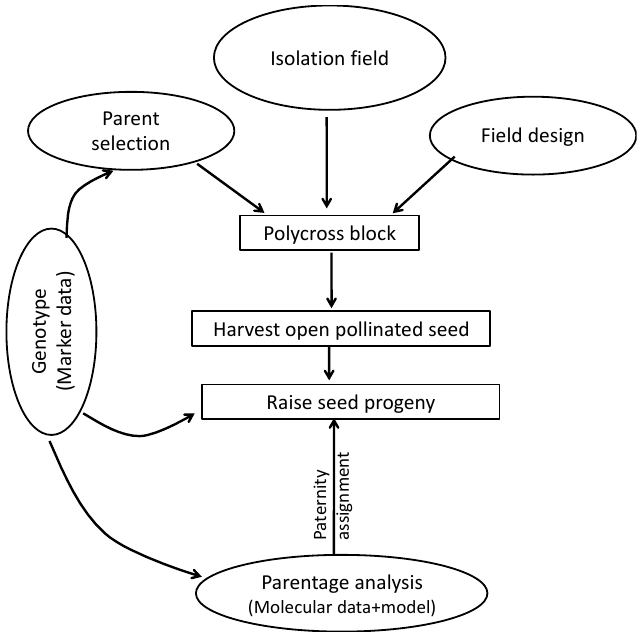
Figure 9. A flow diagram showing the experimental procedure of parentage analysis in white yam.